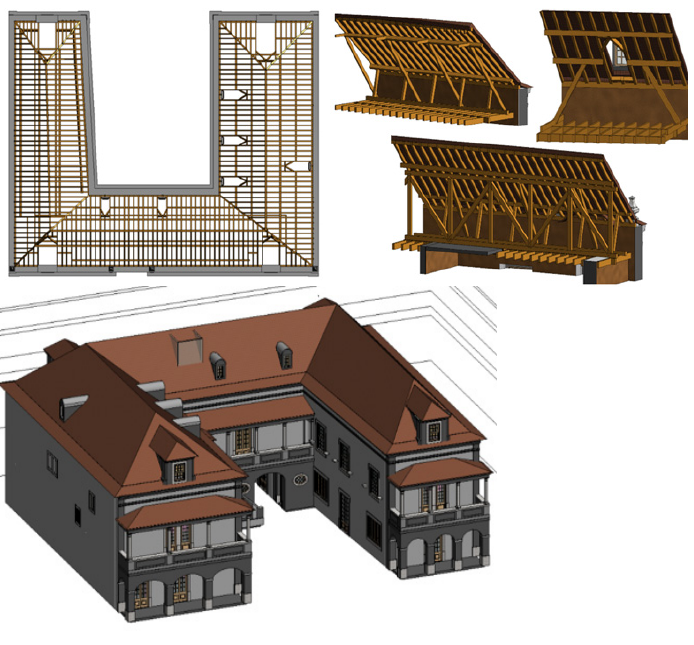
Figure 29. Model of the roof.